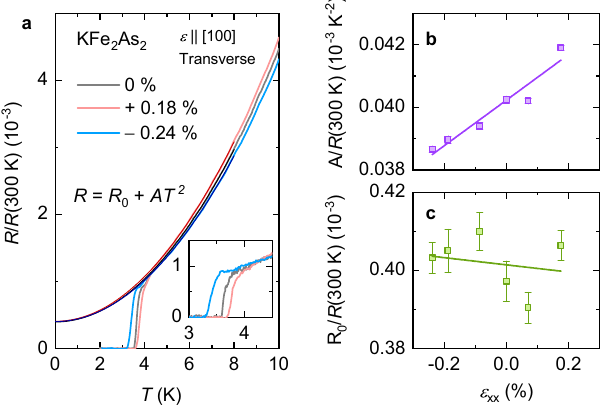
Fig. 3 Resistance at fi xed strain. a Normalized resistance of KFe 2 As 2 as a function of temperature at fi xed strains, along with fi ts to the indicated fi tting function. Inset: zoom of superconducting transitions. b Strain dependence of the fi t parameter A , measuring electronic correlations and effective mass. c Strain dependence of the fi t parameter R 0 , the residual resistance. Lines in b , c are linear fi ts. Error bars represent the standard error of the fi ts.